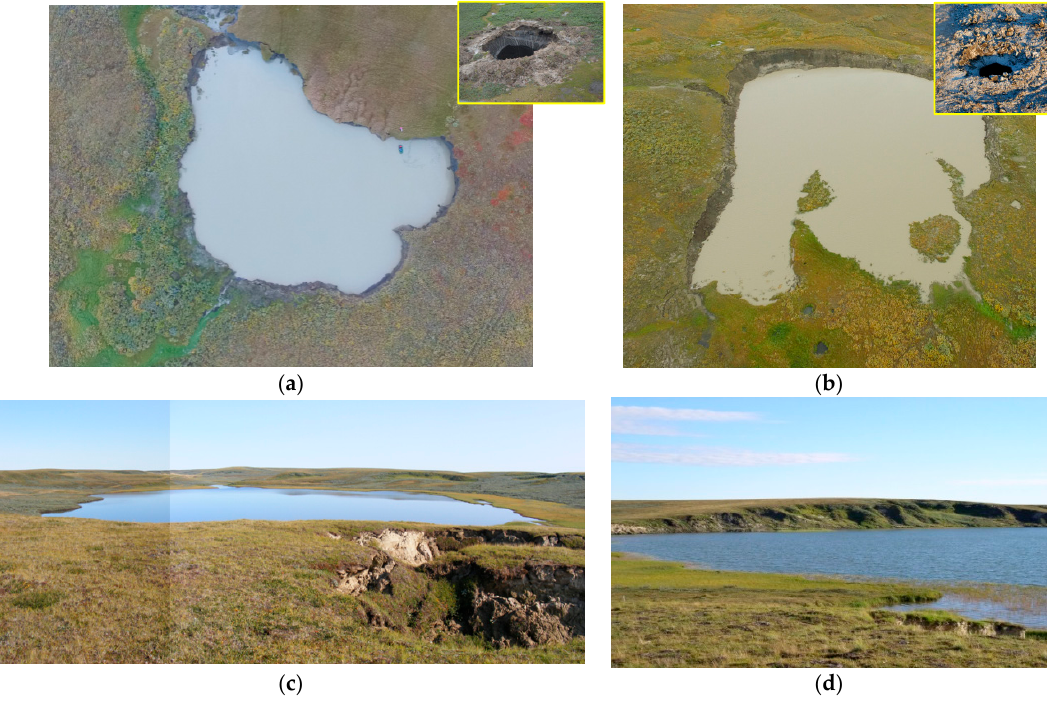
Figure 1. Gas emission crater (GEC) lakes and background lakes in Central Yamal: ( a ) the lake GEC-1 (the photo in the insert shows the initial state of GEC-1); ( b ) the lake GEC-2 (the photo in the insert shows the initial state of GEC-2); ( c ) background Lake 001; ( d ) background Lake